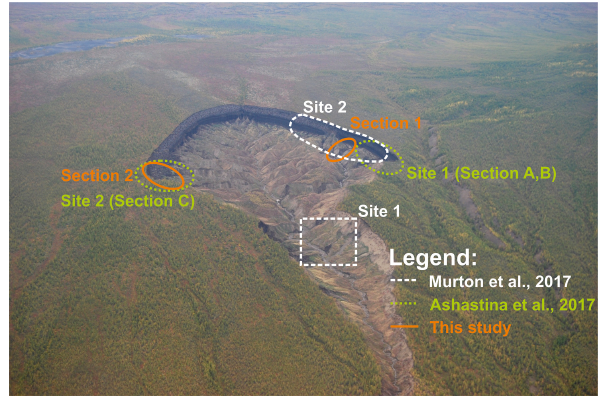
Figure 2. Overview photograph of the Batagay megaslump show- ing the study sites of Ashastina et al. (2017) and Murton et al. (2017) and this study. Photograph taken by Alexander Gabyshev in